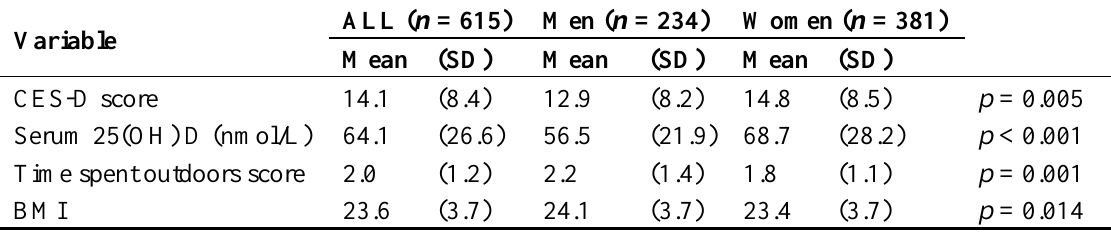
Table 1. Average CES-D score, serum 25(OH) vitamin D, time spent outdoors, and BMI for all participants, and men and women